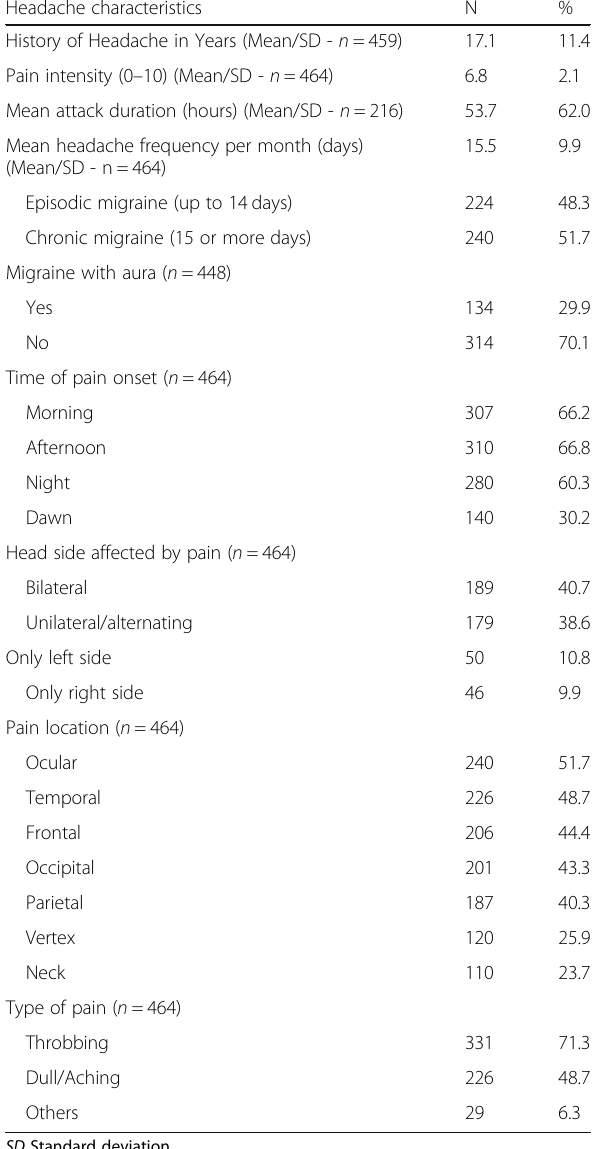
Table 2 Headache characteristics reported by patients Headache characteristics